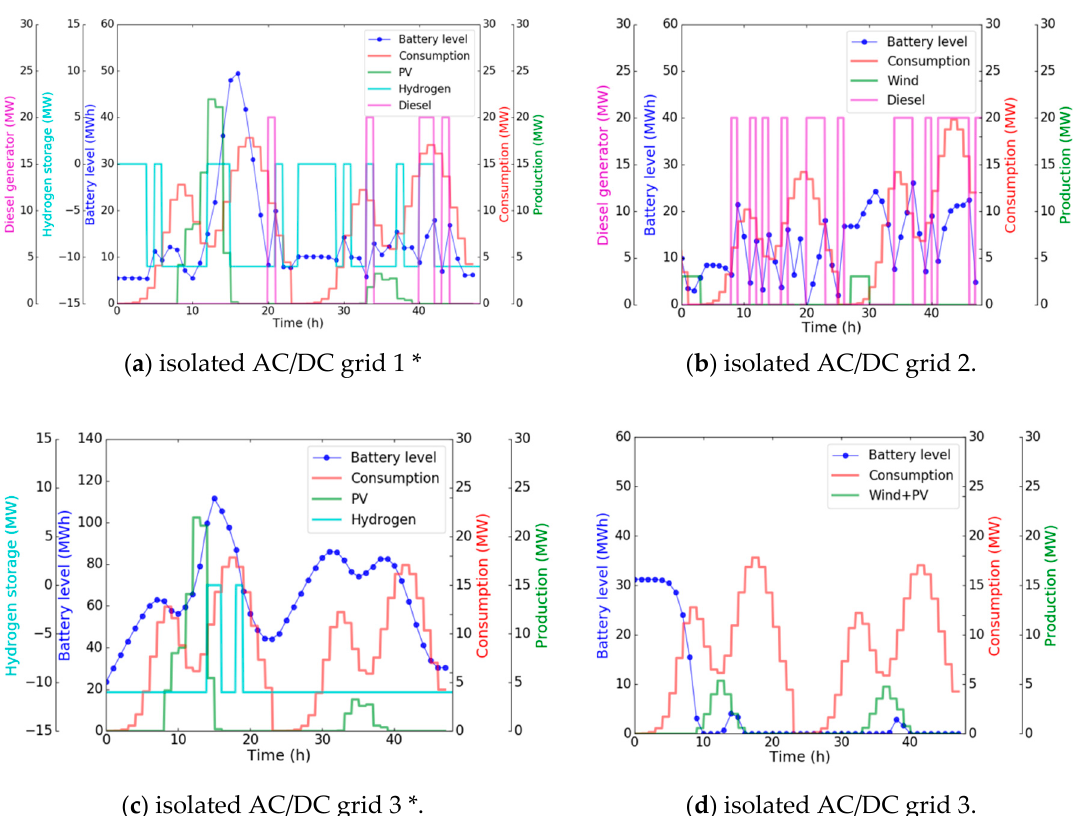
Figure 8. The typical winter policies computed with minimal information available to the DQN-agent for isolated AC/DC grids *.